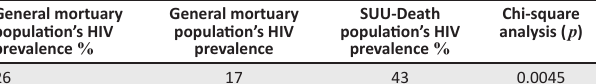
TABLE 4: Chi-square analysis of the general population HIV statistics and sudden, unexplained and unexpected death HIV prevalence statistics.